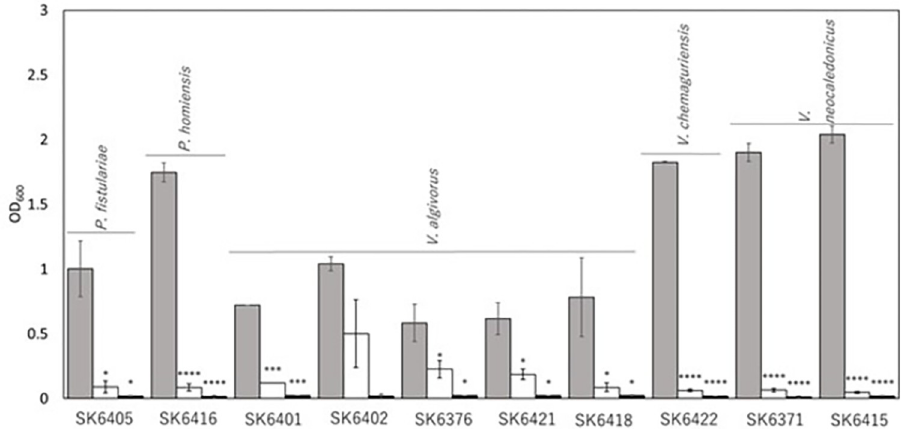
Fig 2. Alginate assimilation by isolated alginate-assimilating bacteria. The bacteria were cultivated in NTA (gray bar, NT plus 0.5% alginate), TA (white bar, NTA minus 3.0% NaCl), and NT (black bar, NTA minus 0.5% alginate) for 3 days. n = 3. � p < 0.05; �� p < 0.01; ��� p < 0.005; ���� p < 0.001 vs. growth in